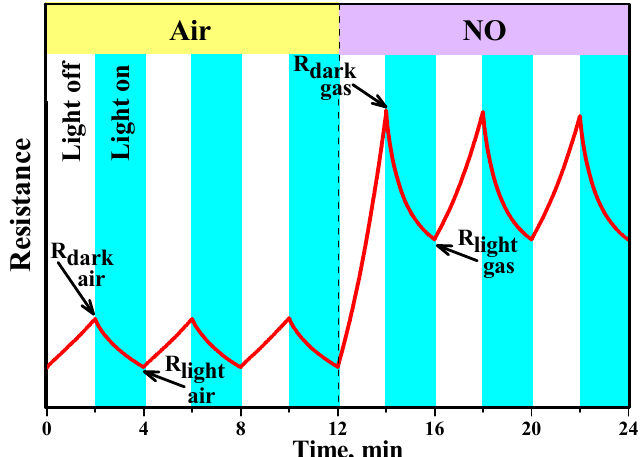
Figure 8. Scheme of changes in the resistance of semiconductor materials under periodic blue light LED illumination ( λ max = 470 nm) in pure air and in the presence of NO.